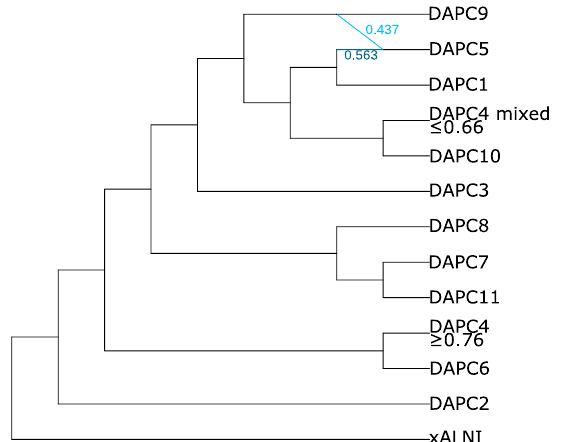
Fig. 5 Phylogenetic network of P. cambivora -related population × groups estimated with the Species Networks applying Quartets (SNaQ) implemented in Phylonetworks with one hybridization event. The blue edges denote the identified hybridization event, with numbers next to the edges denoting the proportion of loci that were transferred from each